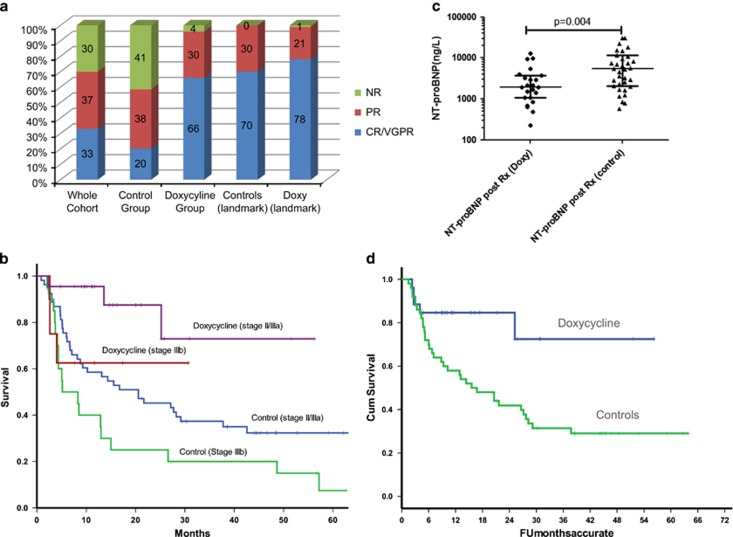
(a) The percentage of haematologic responders in the doxycycline and control groups. On an ITT, the overall response rate was significantly better in the doxycycline-treated group (the patients who died before response assessment are counted as non-responders). However, in the landmark cohort, there is no significant different in the haematologic responses confirming that doxycycline per se does not influence the response to chemotherapy, but only does so by allowing more patients in the treated group to live longer and achieve a response to chemotherapy. (b) Overall survival in the doxycycline-treated and control cohorts divided by the Mayo disease stage. Patients with very advanced cardiac stage IIIb disease (defined as NT-proBNP >8500 ng/l) do not have significant improvement in survival but patients with stage II/IIIa (NT-proBNP <8500 ng/l) have a significant improvement in overall survival when treated with doxycycline compared to matched controls. (c) Significantly greater reduction in NT-proBNP after completion of treatment in the doxycycline-treated group compared to the controls. (d) Survival of patients treated with an upfront bortezomib-based regime stratified by doxycycline vs controls. The median survival was 15 months in the control group and was not reached in the doxycycline group (log rank P=0.012).